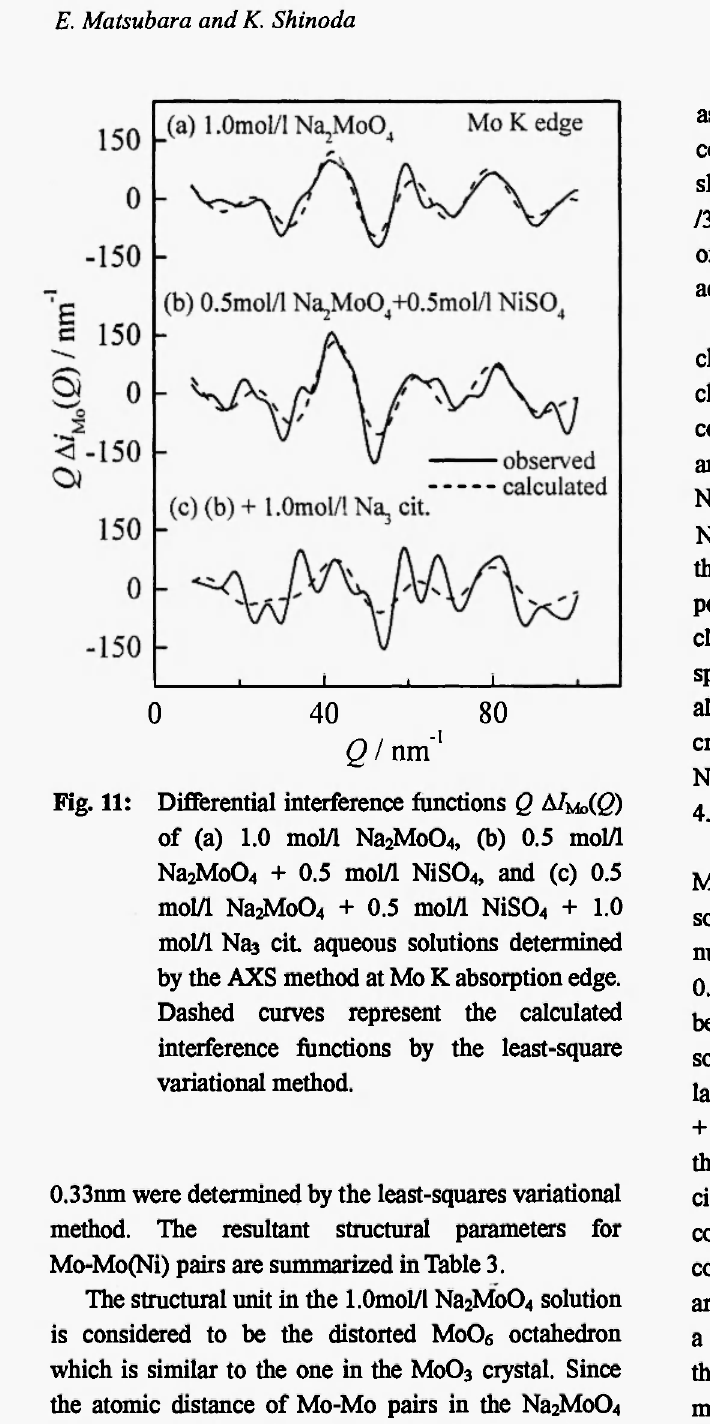
Fig. 11: Differential interference functions Q Δ/μο(0) of (a) 1.0 moW Na Mo0 , (b) 0.5 mol/1 2 4 Na Mo0 + 0.5 mol/1 NiS0 , and (c) 0.5 2 4 4 mol/1 Na Mo0 + 0.5 mol/1 NiS0 + 1.0 2 4 4 mol/1 Na cit aqueous solutions determined 3 by the AXS method at Mo Κ absorption edge. Dashed curves represent the calculated interference functions by the least-square variational